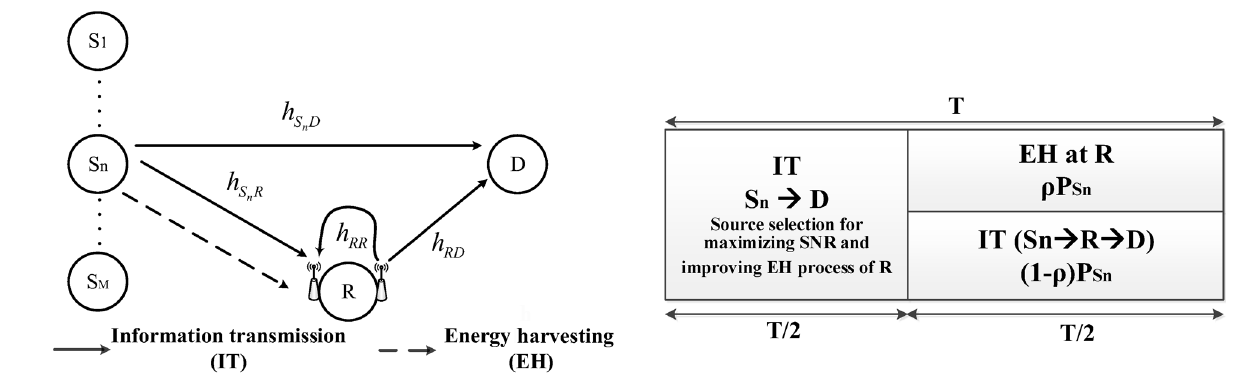
Fig. 2. Energy harvesting and information processing by the adaptive relaying